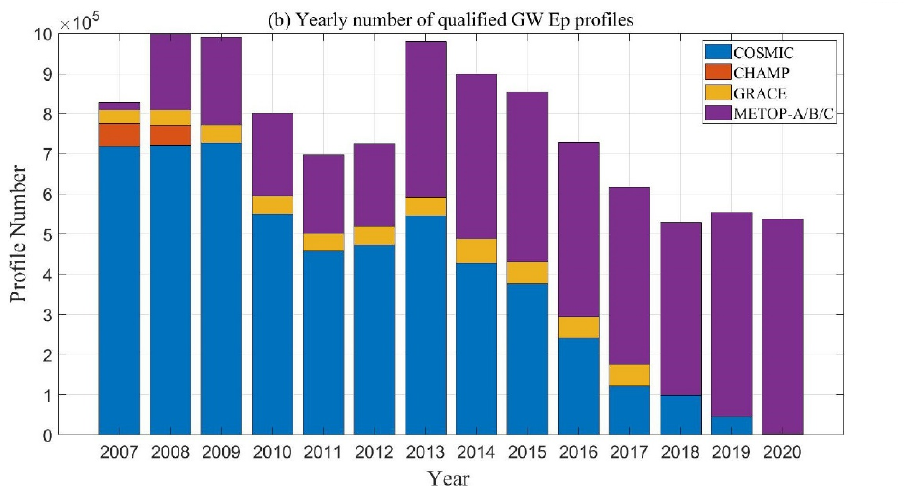
Figure 2. ( a ) Global distribution and ( b ) yearly number of qualified GW Ep profiles derived from the RO observations during 2007–2020.